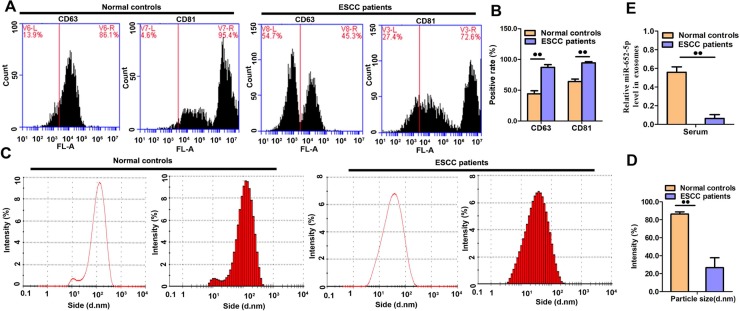
Analyses of serum exosomes and exosomal miRNAs.(A-B) The detection of surface markers CD63 and CD81 in serum exosomes from OSCC patients and healthy participants.(C-D) Size detection of serum exosomes. (E) miR-652-5p level in serum exosomes was measured by qRT-PCR. Results from triplicate experiments are shown.Data are presented as the mean ± SD from triplicate experiments.